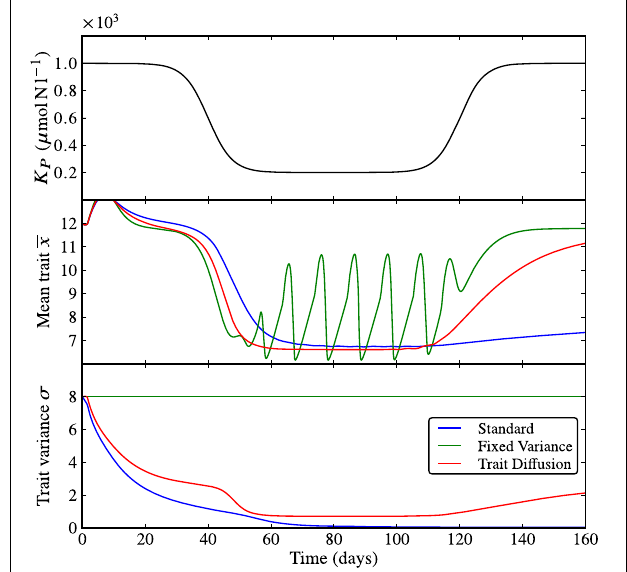
FIGURE 3 | K P shock. As K P transitions from a state of low grazing pressure (i.e., high K P ) to an intermediate period of high grazing pressure (i.e., low K P ), the underlying dynamics shifts from equilibrium to limit cycles. When the grazing pressure is relaxed again (i.e., back to high K P ), the three models show different rates of adaptations. In the standard model, the collapse of the trait variance prevents adequate adaptation as time progresses. Adaptation is fastest in the model with fixed variance and sufficiently fast in the trait-diffusion model. The corresponding NPZ dynamics is shown in Supplementary Figure